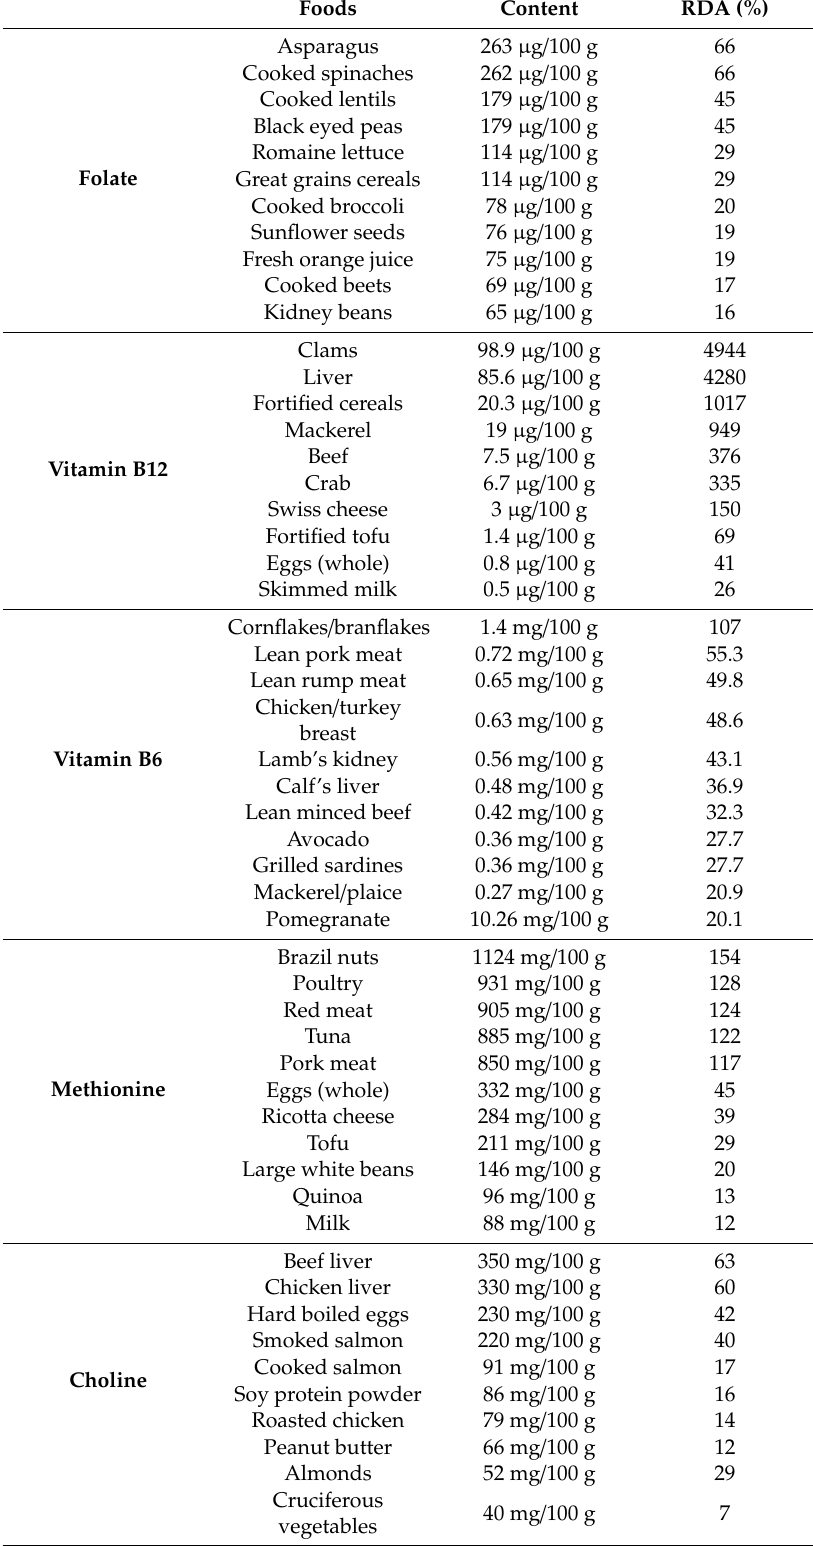
Table 1. Main dietary sources of folate, vitamin B12, methionine, choline, betaine, and vitamin B6, related food content, and RDA (Recommended Dietary